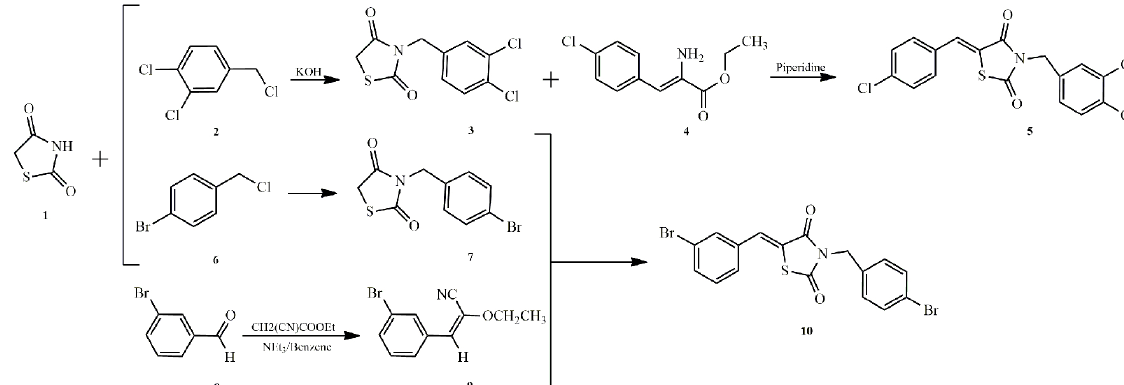
FIGURE 1 - Synthetic route for compounds LPSF/GQ-147 (Z)-5-(4-chlorobenzylidene)-3-(3,4-dichlorobenzyl) thiazolidine-2,4- dione (nº 5) and LPSF/CR-35 (Z)-3-(4-bromobenzyl)-5-(3-bromobenzylidene) thiazolidine-2,4-dione (nº